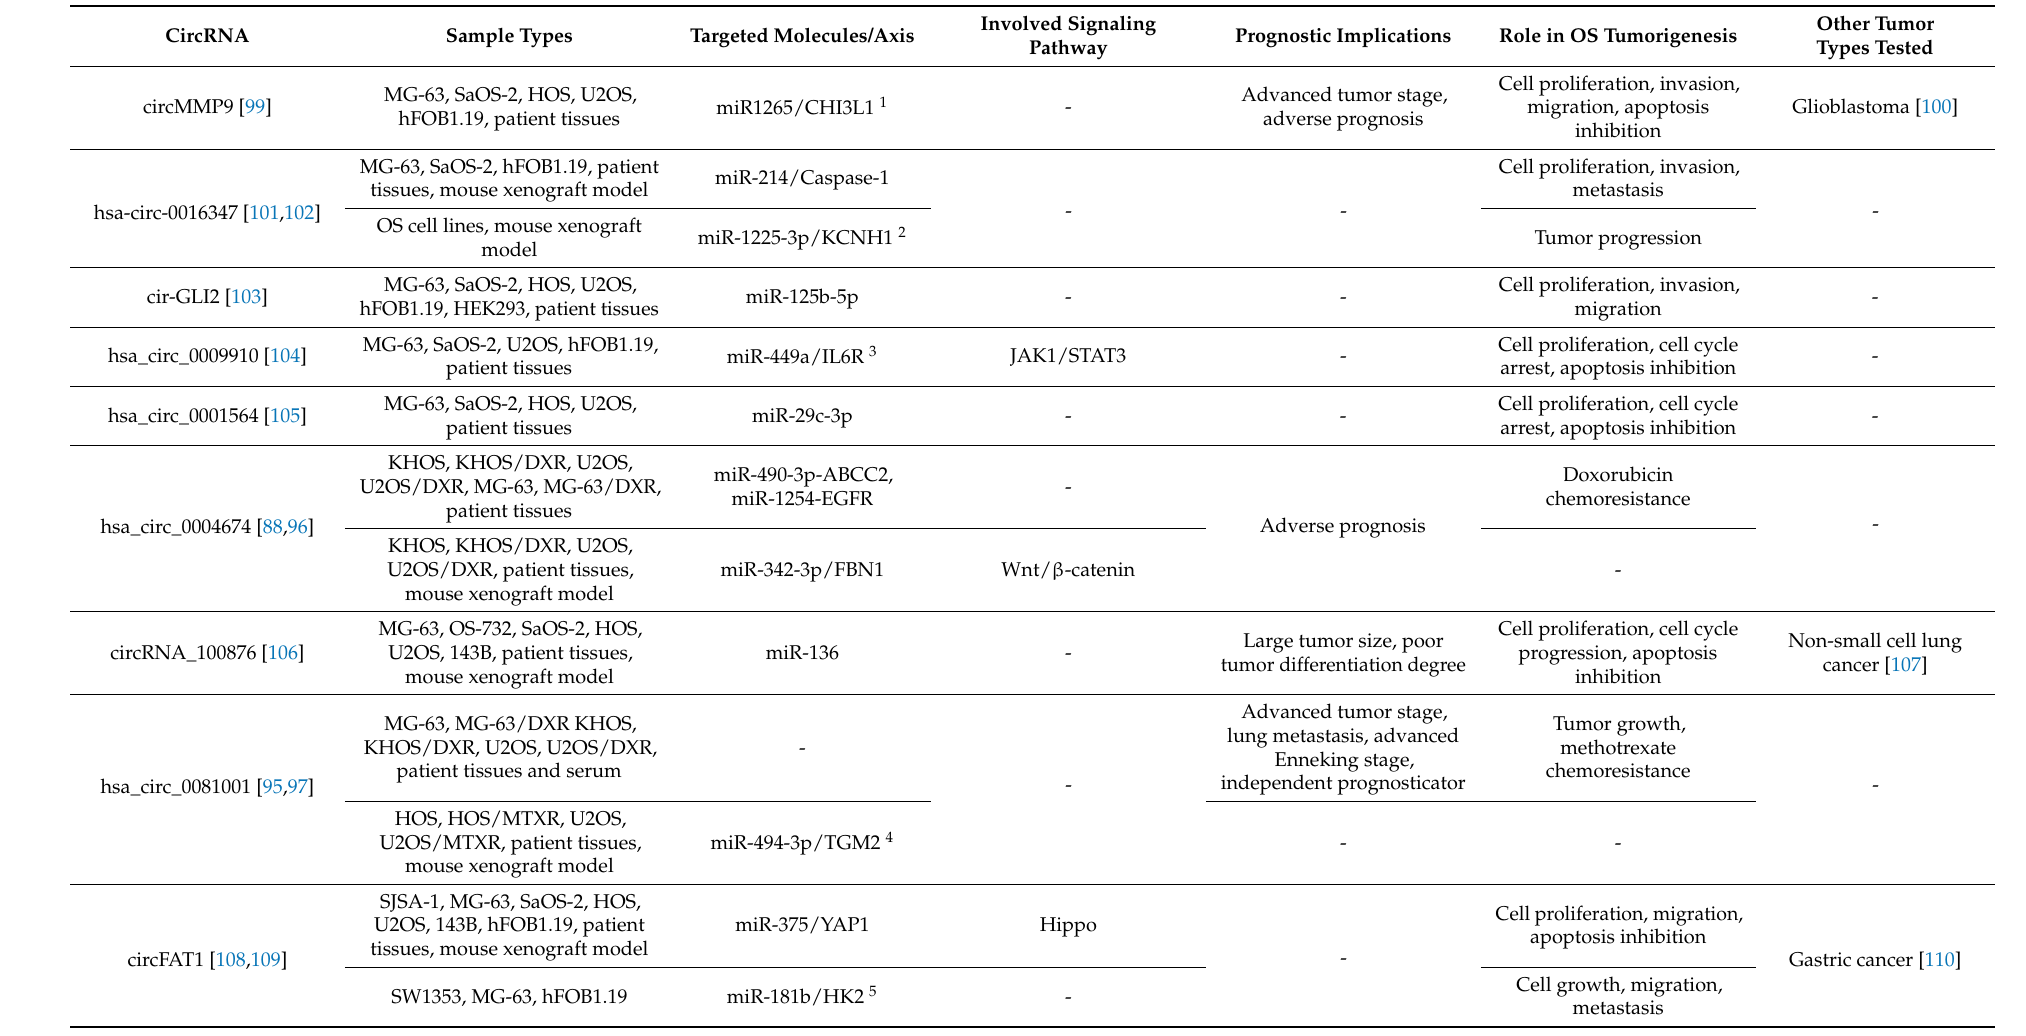
Table 1. Upregulated circRNAs in